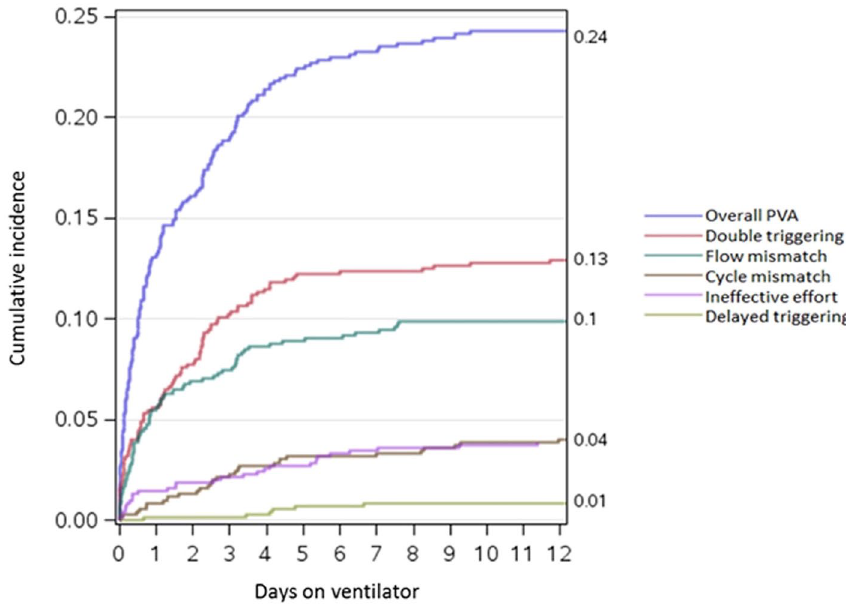
Figure1. Cumulative incidence of asynchrony over the first 12 days of mechanical ventilation.